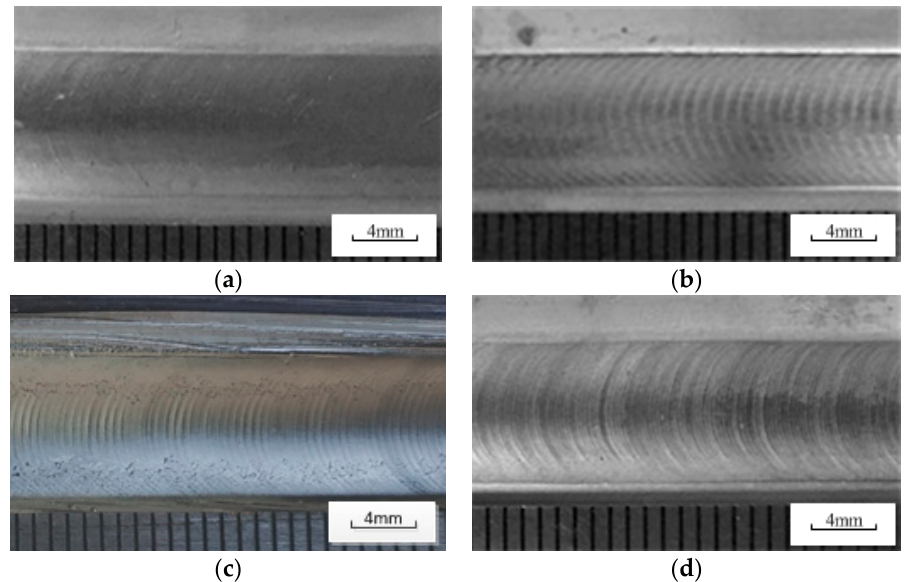
Figure 11. Morphology of weld surface. ( a ) VPPAW; ( b ) DP-VPPAW; ( c ) PPG-VPPAW (20 Hz); ( d ) PPG-VPPAW (40 Hz).